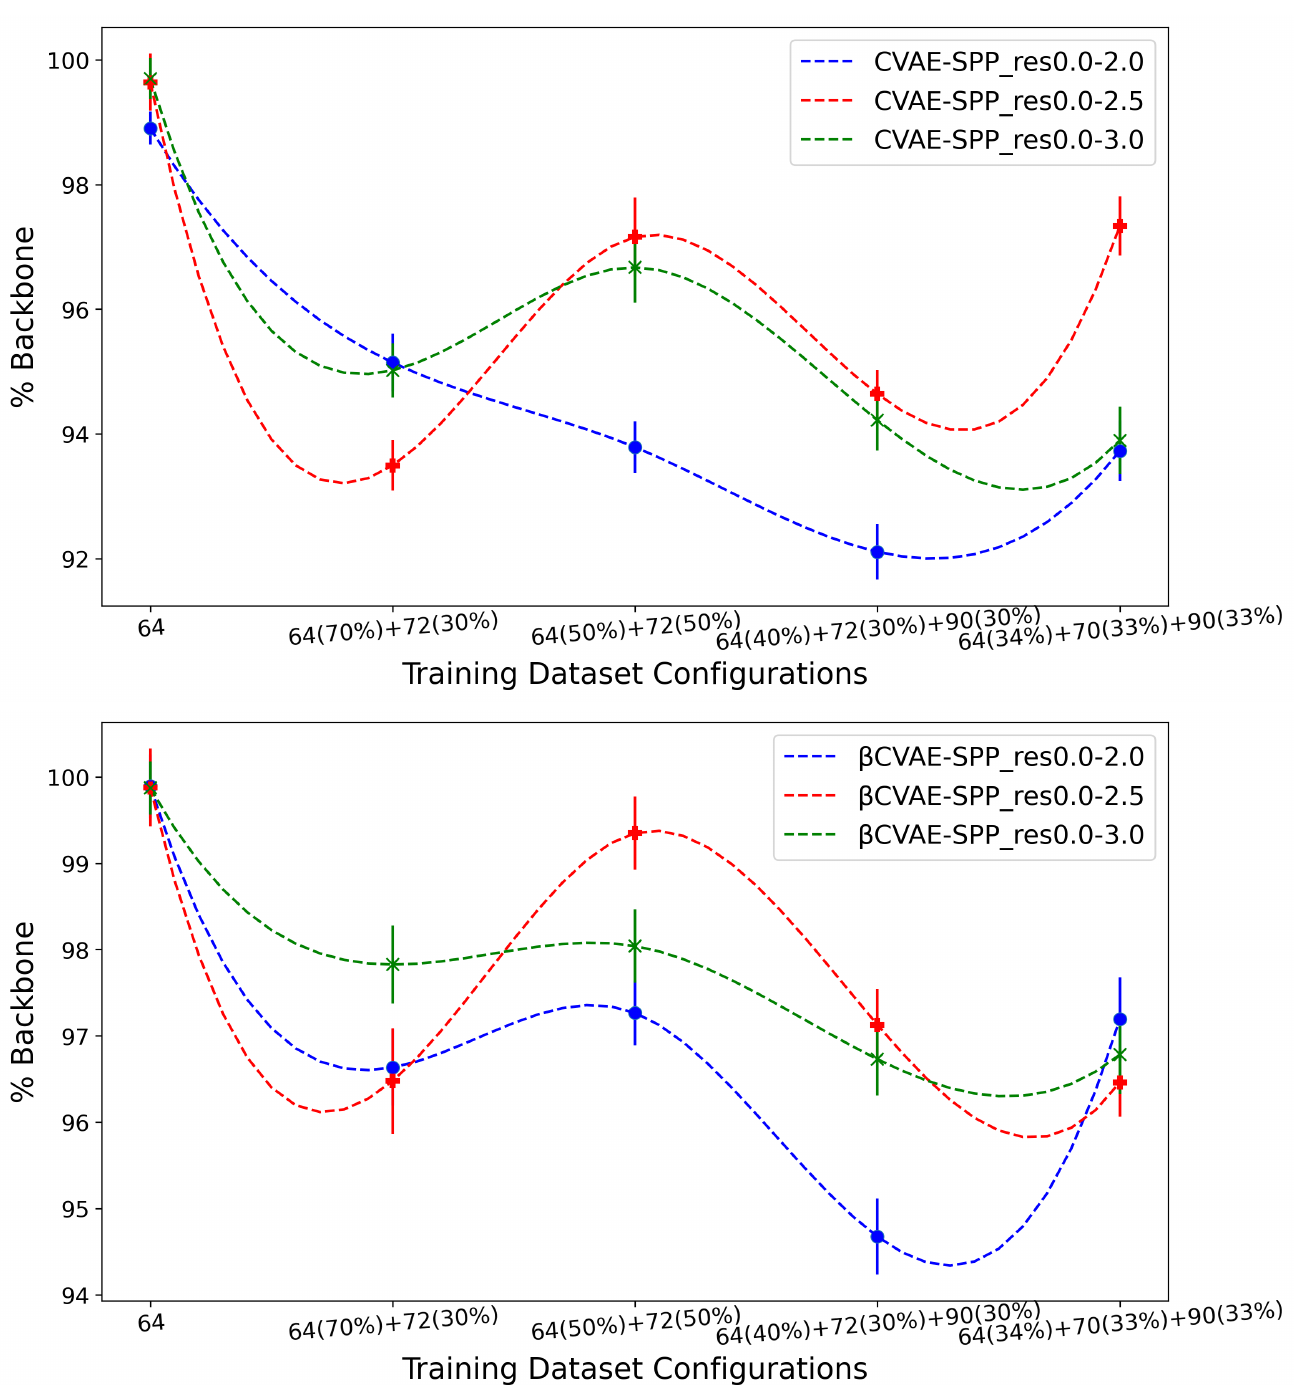
Figure 6. The (average) percentage of backbone over generated data for the CVAE-SPP (top panel) and β CVAE-SPP model (bottom panel) is compared along the five training dataset configurations for each of the three input